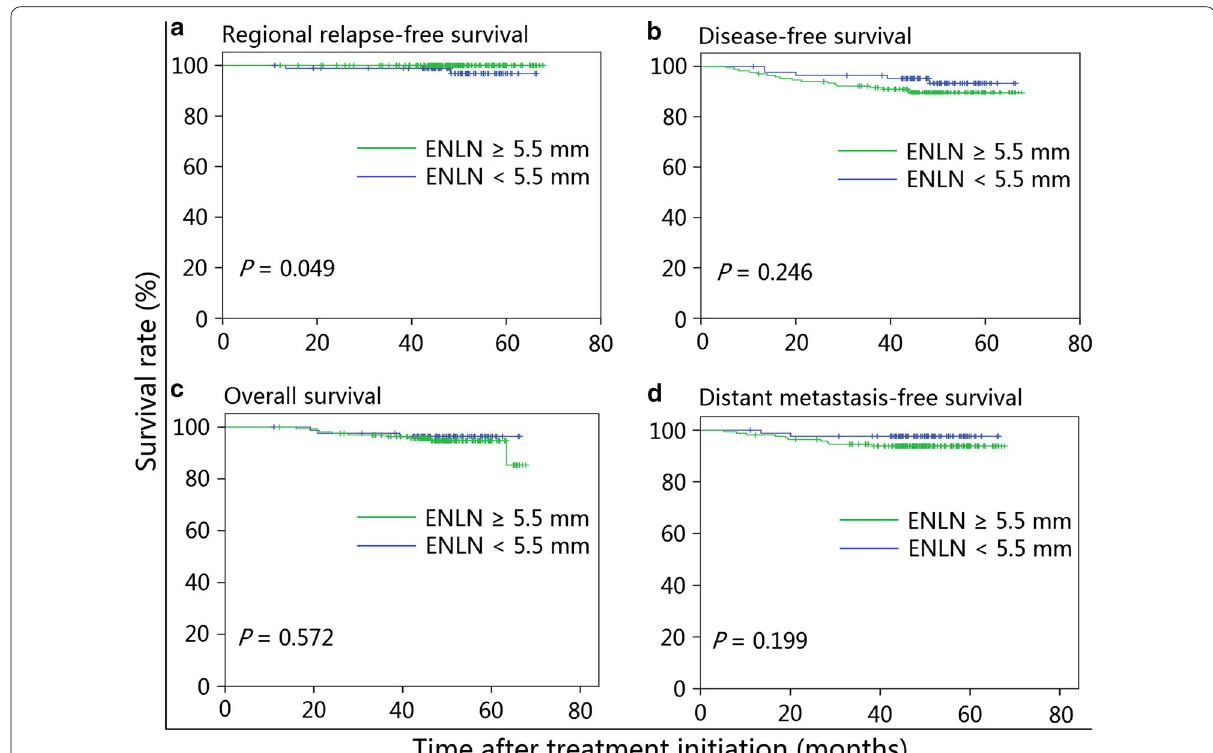
Fig. 2 Kaplan–Meier survival curves of patients with N0‑category NPC and ENLN in the small ENLN (<5.5 mm) and large ENLN ( a Regional relapse‑free survival; b disease‑free survival; c overall survival; d distant metastasis‑free survival. NPC nasopharyngeal carcinoma, ENLN small neck lymph